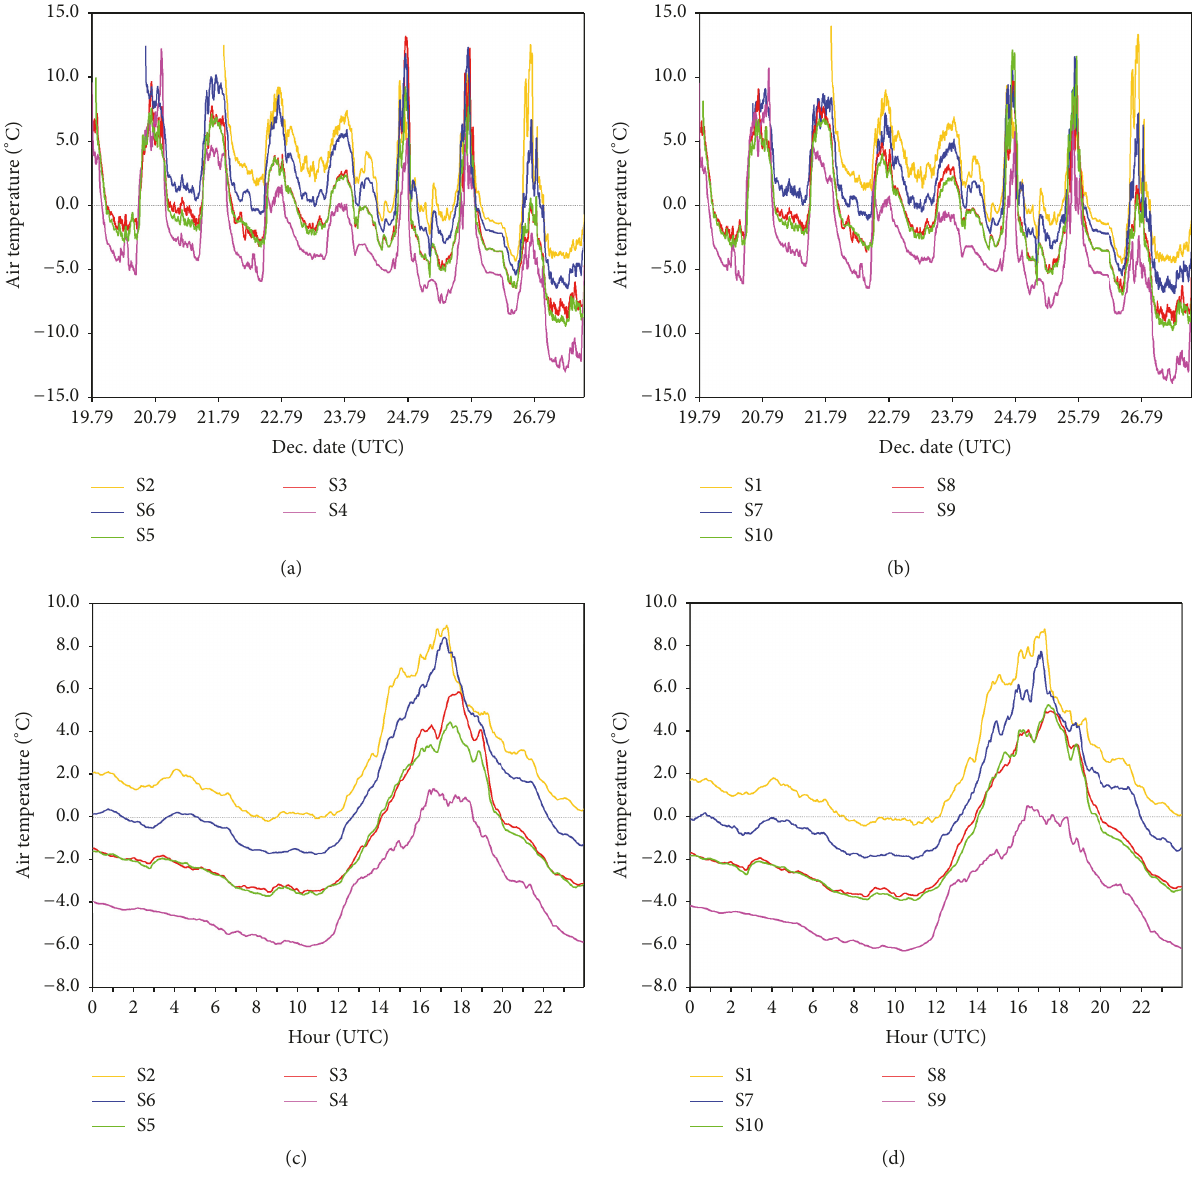
Figure 6: (a) 2-m surface air temperature profiles at the Tinytag sensors S2, S6, S5, S3, and S4 (moving progressively up the glacier), based on 1-min data; (b) 1-m surface air temperature profiles at the Tinytag sensors S1, S7, S10, S8, and S9 (moving progressively up the glacier), based on 1-min data; (c) mean daily 2-m surface air temperature profiles (22–26 March 2015) for the same stations/sensors as in Figure 6(a);